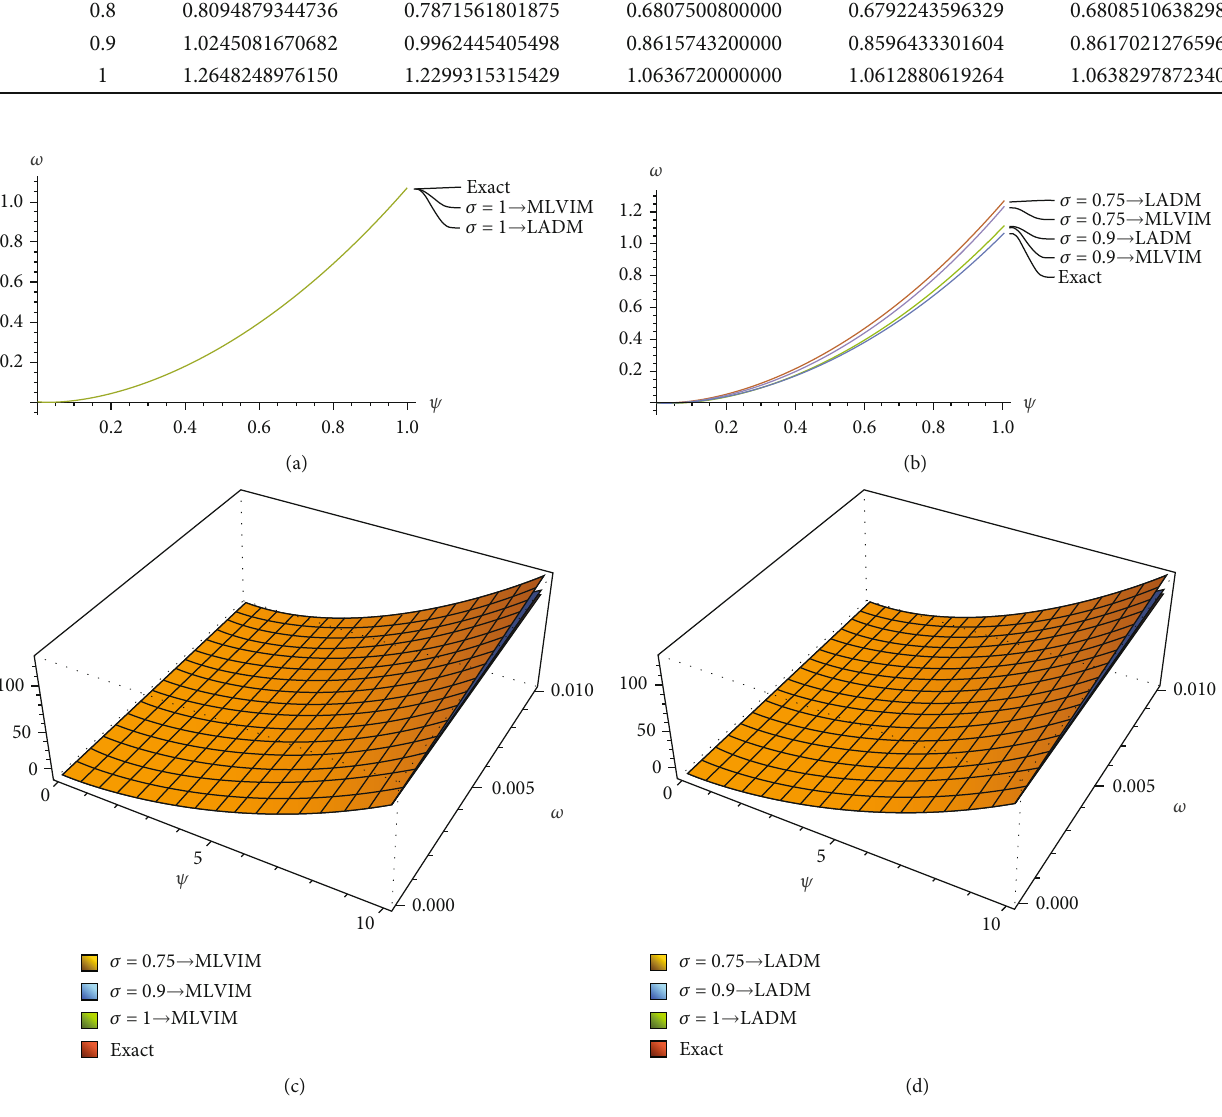
Figure 3: Comparison of LADM and MLVIM solution for the fi rst three approximations with exact solution for ω = 0 : 01 , with mesh points ψ = 0 : 1 , for equation (44).